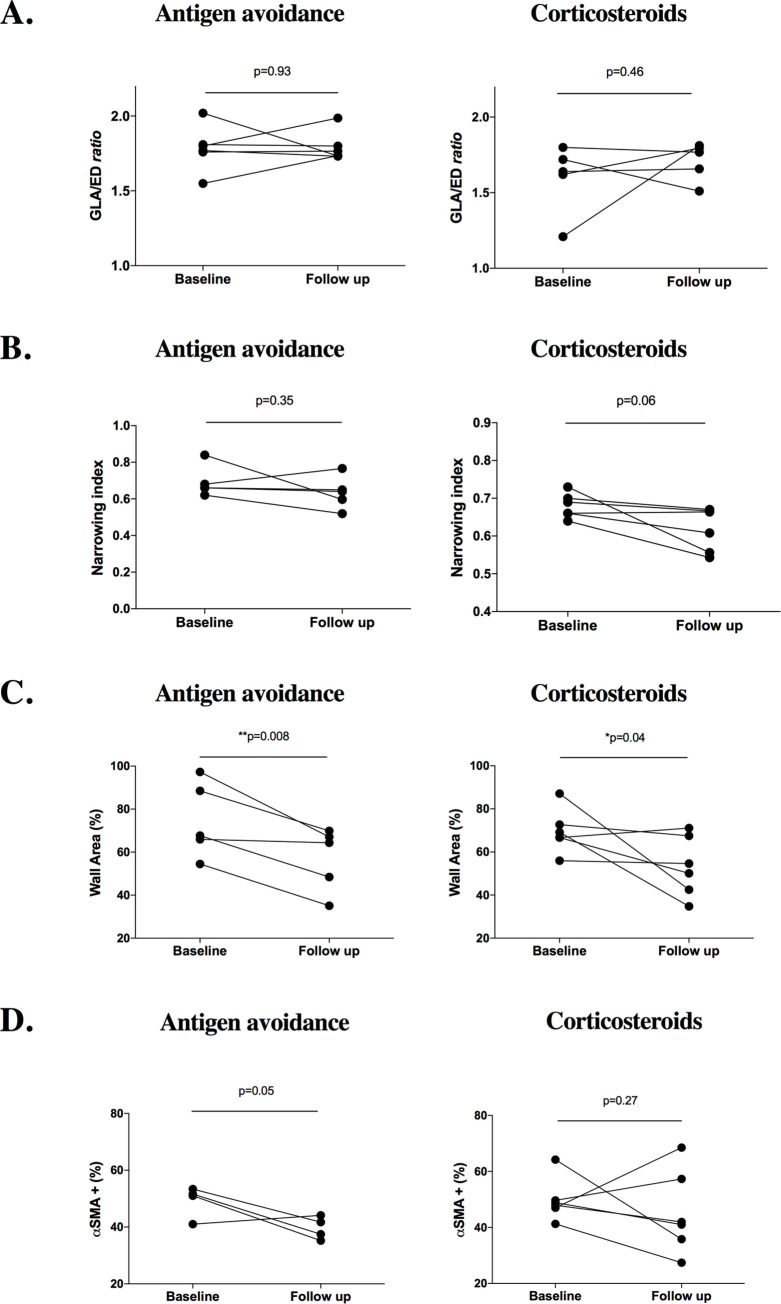
Summary of study 3 results.Comparison between baseline and follow up in both groups of GLA (great longitudinal axis)/ED (external diameter) ratio (6a), narrowing index (6b), wall area % (6c), α-SMA+ (α-smooth muscle actin positive) area % (6d). A significant reduction of the wall thickening (wall area%) was observed at the follow-up in both groups, although reduction was more uniform in the antigen avoidance group.